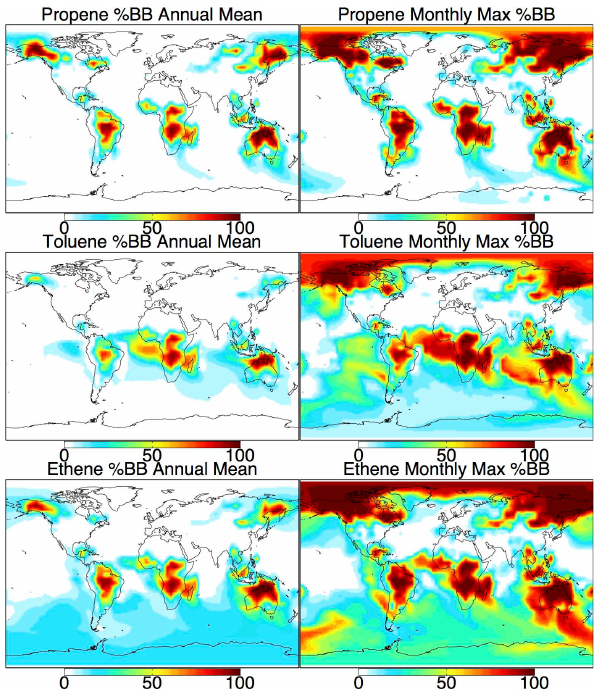
Fig. 5. Fractional contribution to the total propene (top) toluene (middle) and ethene (bottom) from biomass burning. Left hand plots show annual mean contributions and right hand plots the monthly maximum fraction from biomass burning.